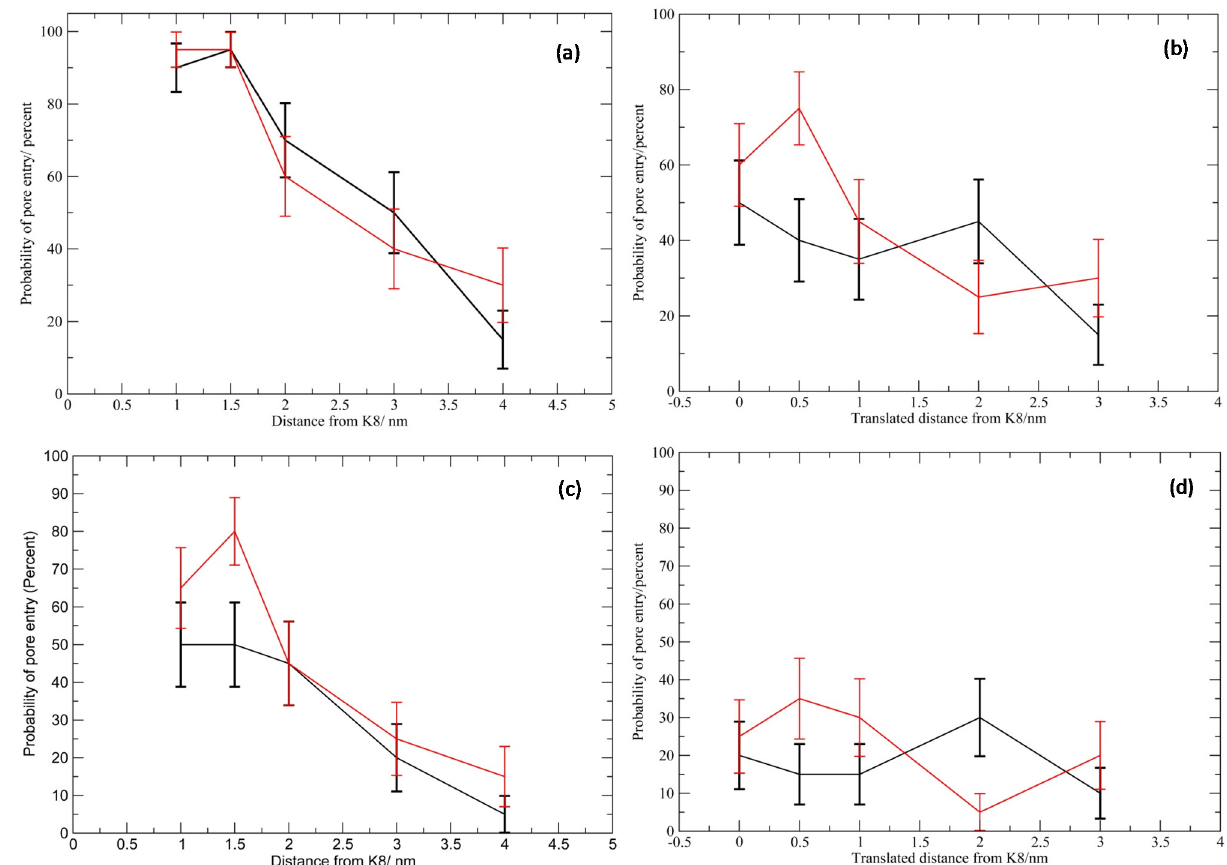
Figure 2. Plots showing the relaionship between release loction and probability of capture. The highest possible probability of entry for ( a ) the distance study and ( b ) the displacement study, e.g., these are the simulations where either capture or possible capture is observed. The lowest possible probability of entry for ( c ) the distance study and ( d ) the displacement study, e.g., these are the simulations where capture is observed. The black lines are for the phosphate up orientation and the red lines are the phosphate down orientation. Error bars were calculated by using the standard error, treating the data as a binomial